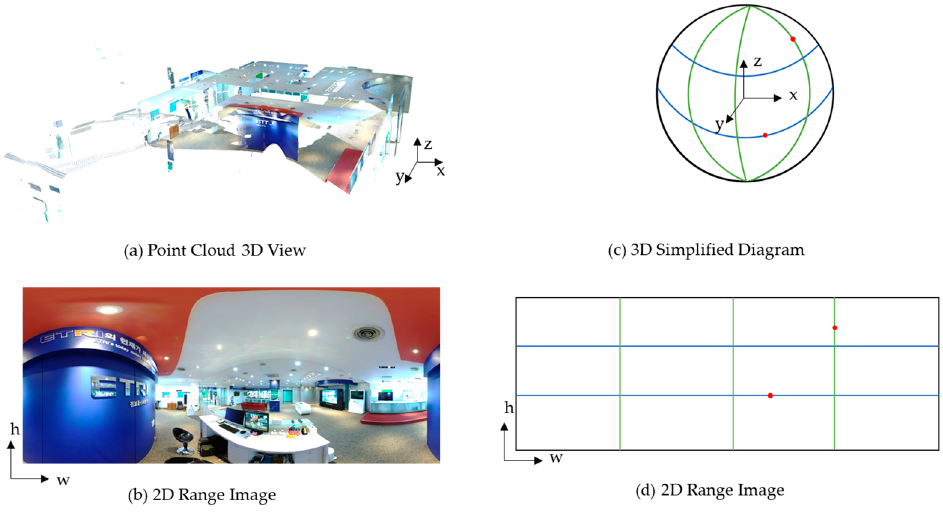
Figure 4. Point cloud to range image schematic. The red dot in the figure represents part of the point cloud data, and the range image can be obtained by topology expansion.